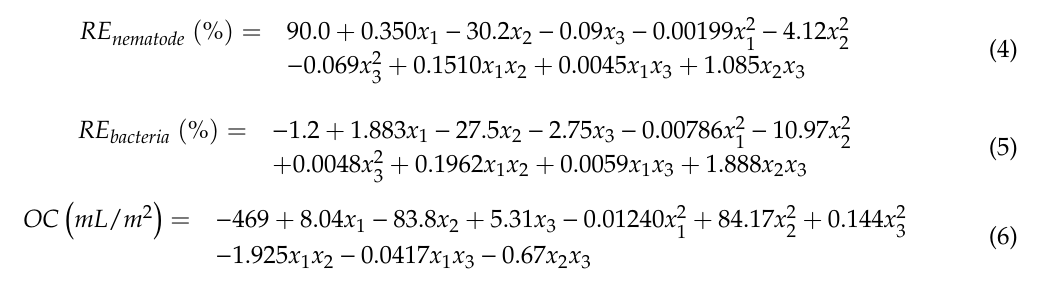
Figure 2. Response surface plots presenting the interaction effects of three variables on the total nematode removal efficiency: ( a ) surface plot showing the effect of the steam temperature and running speed on the removal efficiency, ( b ) surface plot showing the effect of the steam temperature and spray depth on the removal efficiency, and ( c ) surface plot showing the effect of the running speed and spray depth on the removal efficiency. Figure 3 shows the effects of two explanatory variables and their interactions with the response of total bacteria removal efficiency at the middle level of another variable. Similar to the response of the nematodes, interactions between the steam temperature and running speed and between the running speed and spray depth were observed. At the high steam temperature level (160 °C), the removal efficiency decreased from 93.46 to 87.10% when the running speed was increased from 1.0 to 2.0 m/min. At the low steam temperature level (120 °C), the removal efficiency decreased from 95.49 to 81.28% when the running speed was increased from 1.0 to 2.0 m/min (Figure 3a). In addition, at the high running speed level (2 m/min), the removal efficiency increased from 81.48 to 93.28% when the spray depth was increased from 9 to 15 cm. However, at the low running speed level (1 m/min), few changes were observed in the removal efficiency (Figure 3c).